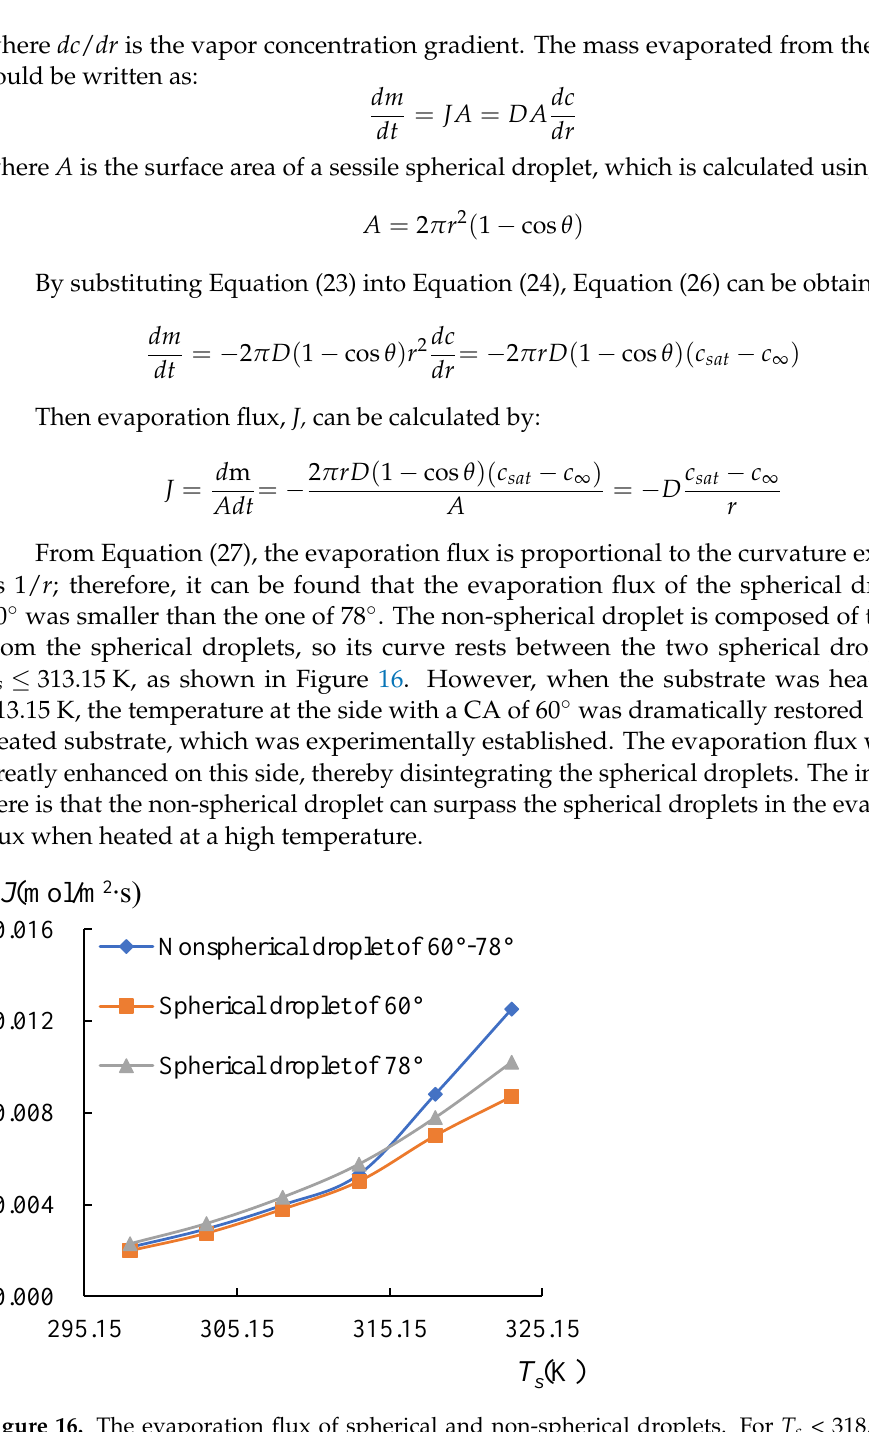
Figure 16. The evaporation flux of spherical and non-spherical droplets. For T s < 318.15 K, the evaporation flux of the non-spherical droplet (60 ◦ –78 ◦ ) lies between the ones of spherical droplets (60 ◦ and 78 ◦ ), however when T s ≥ 318.15 K, the non-spherical droplet surpasses spherical droplets.